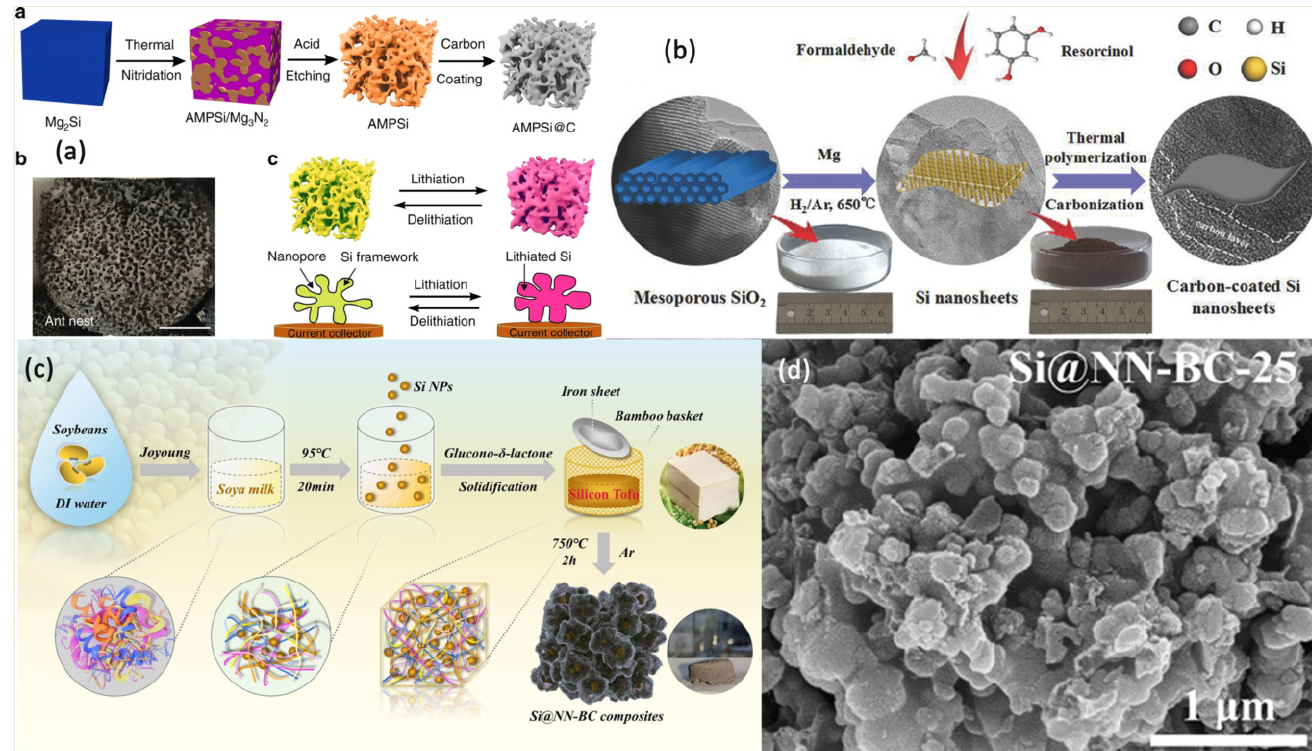
Figure 2. ( a ) Schematic diagram of AMPSi and AMPSi@C preparation and image of ant nests. Reproduced with permission [66]. Copyright 2019, Nature Communications. ( b ) Schematic illustration of the synthesis of nanosheets (inset: the large-scale products of SiO 2 precursors (1.5 g) and Si nanosheets (0.63 g) synthesized one time). Reproduced with permission [67]. Copyright 2018, Wiley Online Library. ( c ) Schematic synthesis of the Si@NN-BC composites derived from silicon tofu, and ( d ) SEM images of Si@NN-BC-25. Reproduced with permission [68]. Copyright 2021, ACS